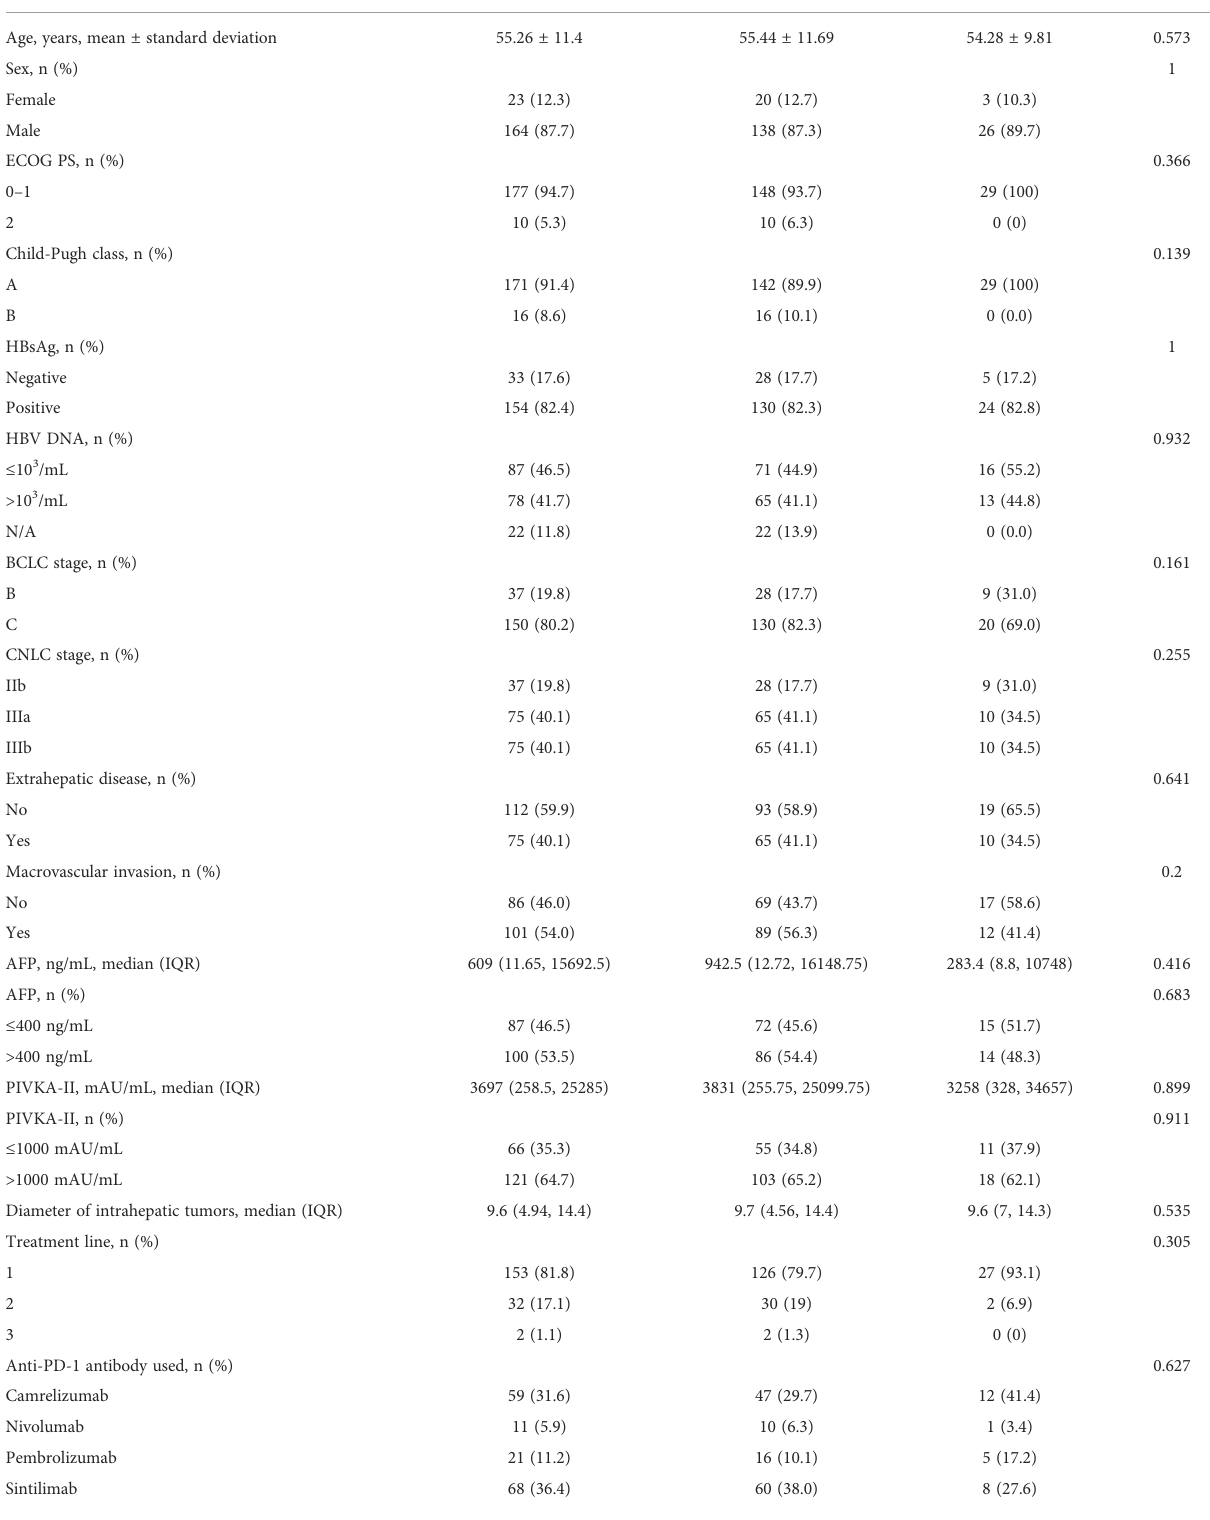
TABLE 1 Clinicopathologic features and response in patients who did or did not undergo